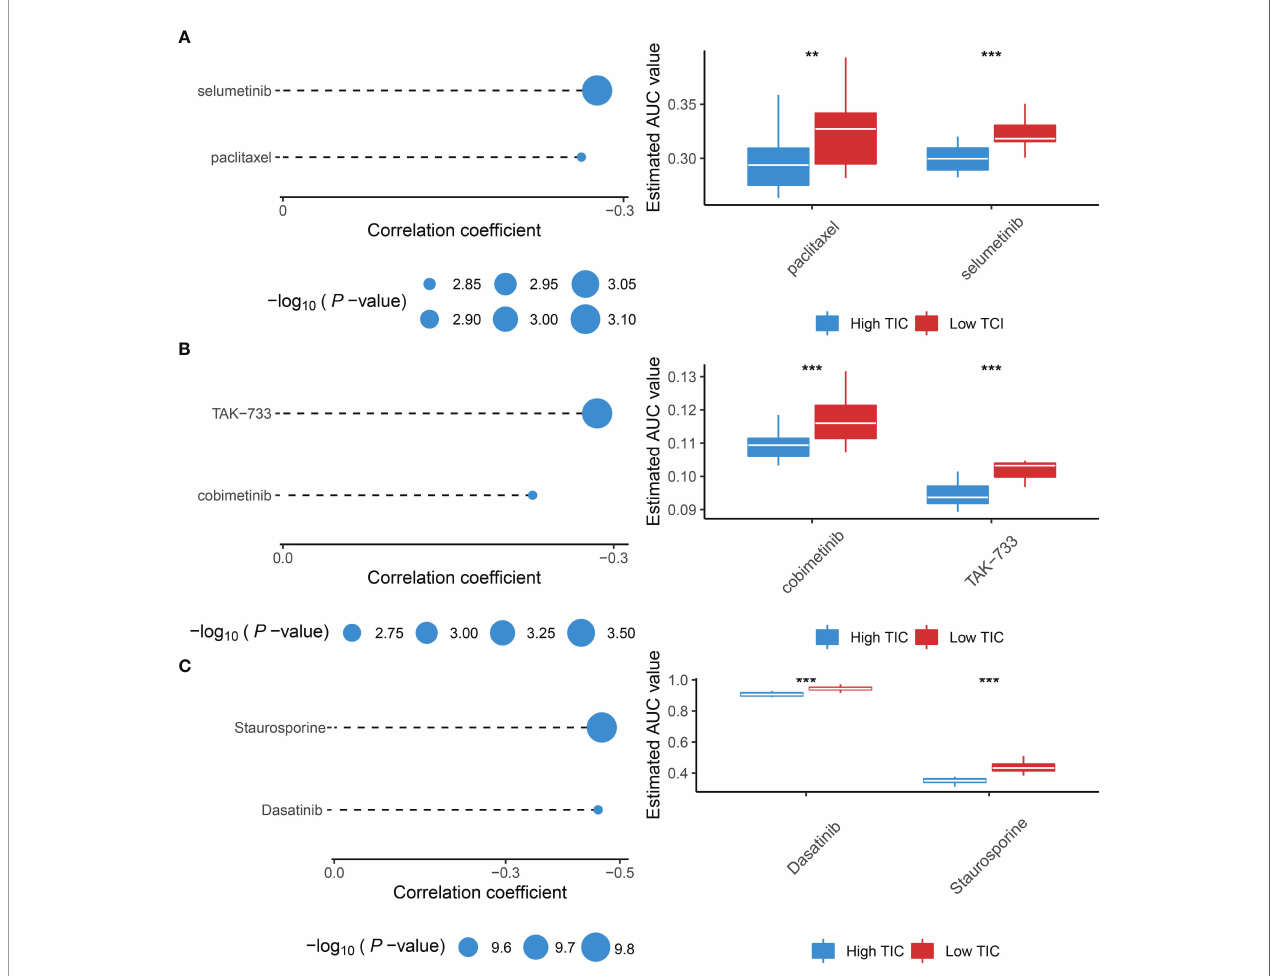
FIGURE 8 | Identi fi cation of therapeutic agents for the low-TIC score group. (A) The correlation analysis between TIC scores and AUC values of selumetinib and paclitaxel in the CTRP database. (B) The correlation analysis between TIC scores and AUC values of cobimetinib and TAK-733 in the PRISM database. (C) The correlation analysis between TIC scores and AUC values of dasatinib and staurosporine in the GDSC database. ** p < 0.01; *** p <